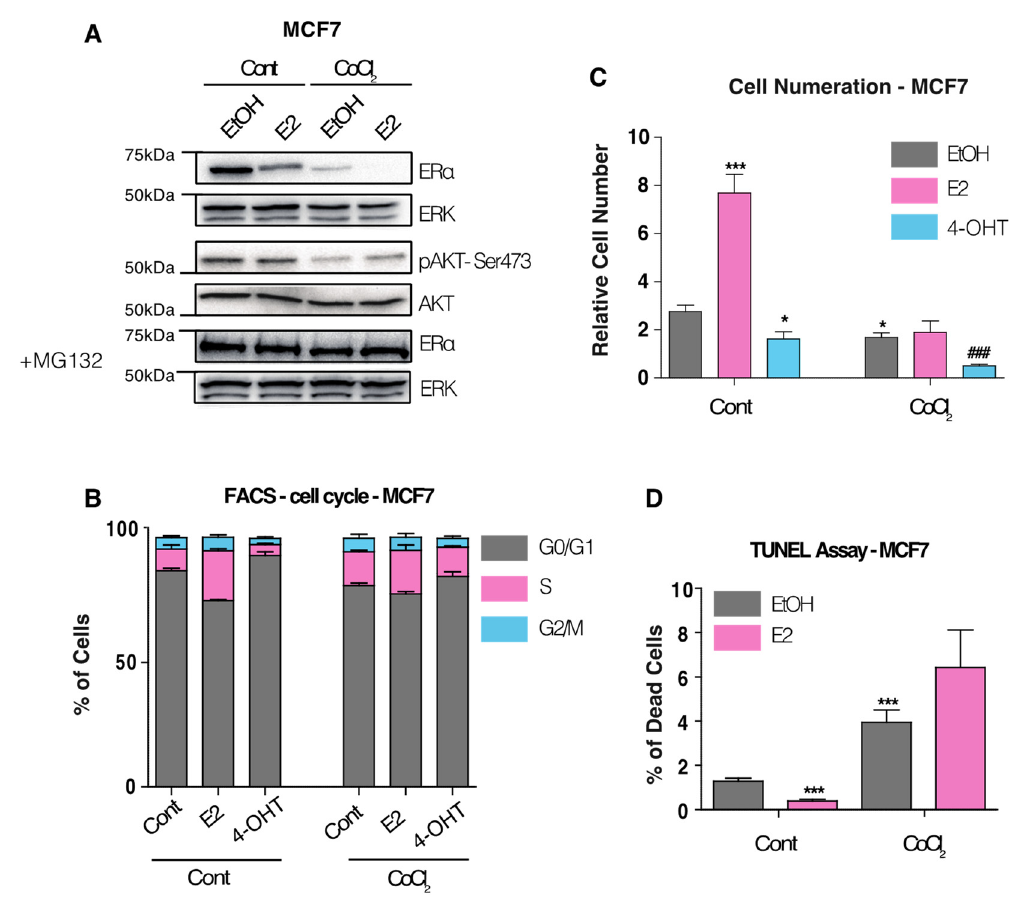
Figure 1. Effect of hypoxia on ER α expression, proliferation and survival of MCF7 cells. ( A ) Western blot showing ER α protein abundance after 1-month exposure to hypoxia inducer CoCl2, in the presence or absence of 10 nM of E2 for 24 h. For proteasome inhibition, cells were treated for 8 h with 2.5 µ M of MG-132. ERK1/2 was used as the normalizing control. pAKT Serine 473 and total AKT abundance were also measured. ( B ) Proliferation count of MCF7 cells treated for 6 days with EtOH, 10 nM E2 or 1 µ M 4OHT, in presence of 2% of FBS steroid-free. Values are expressed in fold change compared to the number of seeded cells at the beginning of the treatment. ( C ) Cell cycle analysis using FACS using propidium iodide. MCF7 cells were treated for 48 h with EtOH, 10 nM E2 or 1 µ M 4-OHT. ( D ) TUNEL assay showing percentage of cell death between control and CoCl2-treated cells, in presence or absence of 10 nM of E2 for 72 h. * p -value < 0.05 and *** p -value < 0.001 with a Mann–Whitney test for comparisons against the control. ### p -value < 0.05 with a Mann–Whitney test for comparisons against CoCl2